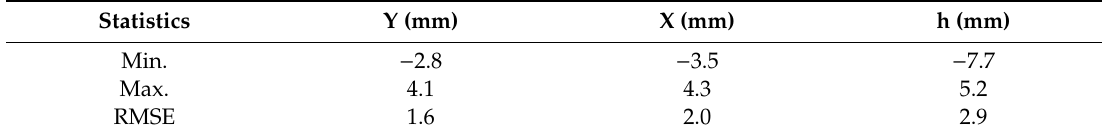
Table 3. Elementary residual statistics for